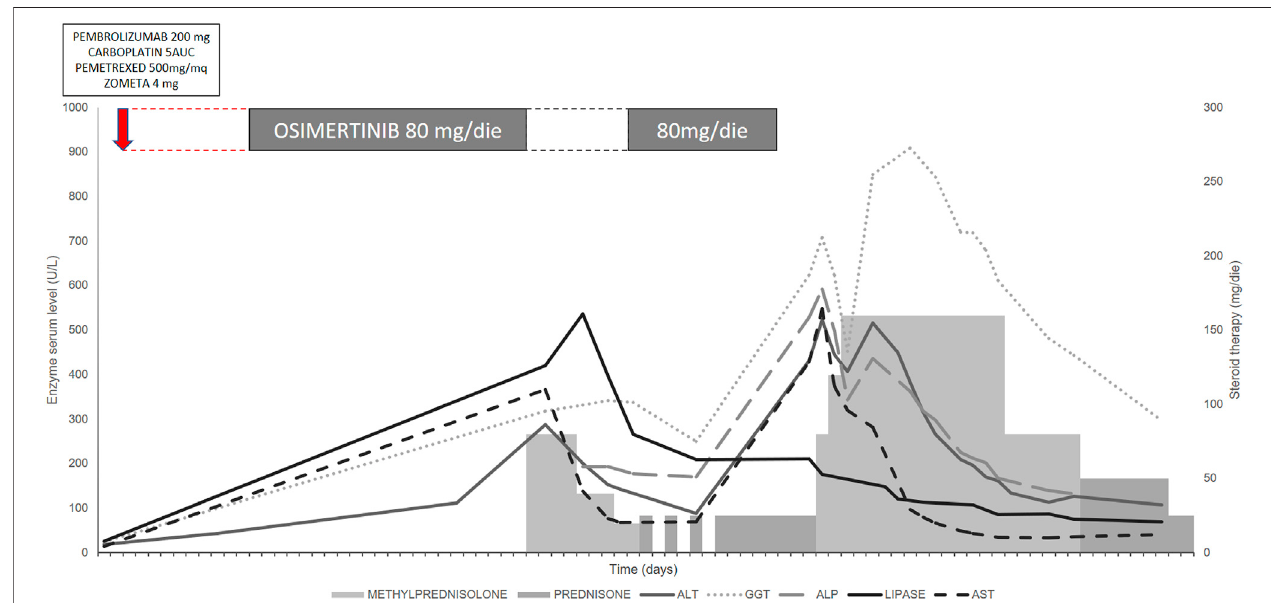
FIGURE1| Serumenzymetrendduringtreatmentwithosimertinibafterchemotherapy+pembrolizumabandconcomitantsteroidtherapy.Themodi fi cationofliver enzymesindicatedgrade(G)3liverinjury,withimportantalterationsinalkalinephosphatase(ALP),gamma-glutamyltransferase(GGT),aspartatetransaminase(AST)and alanine transaminase (ALT). Although the interruption of osimertinib and the concomitant use of steroids reduced the altered enzyme values, an insuf fi cient interval between the adverse event and osimertinib rechallenge rapidly induced new toxicity that took several days to resolve.